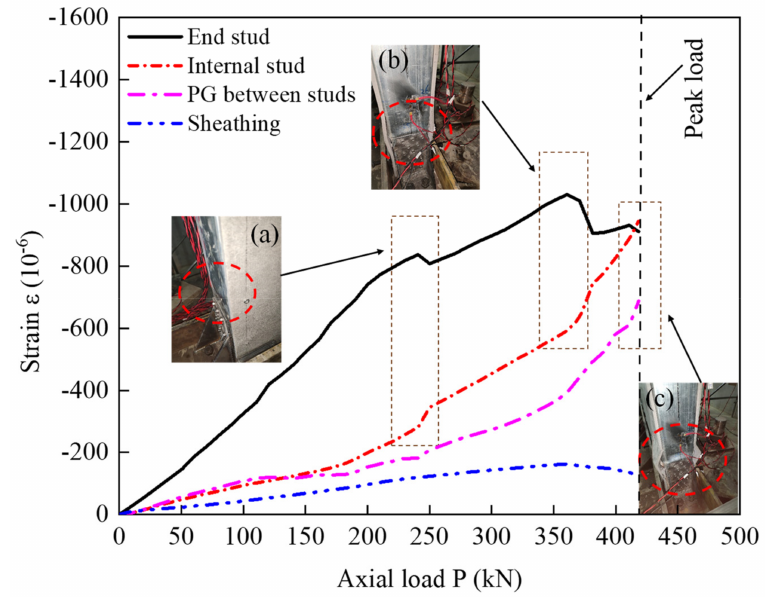
Figure 16. Strain analysis of